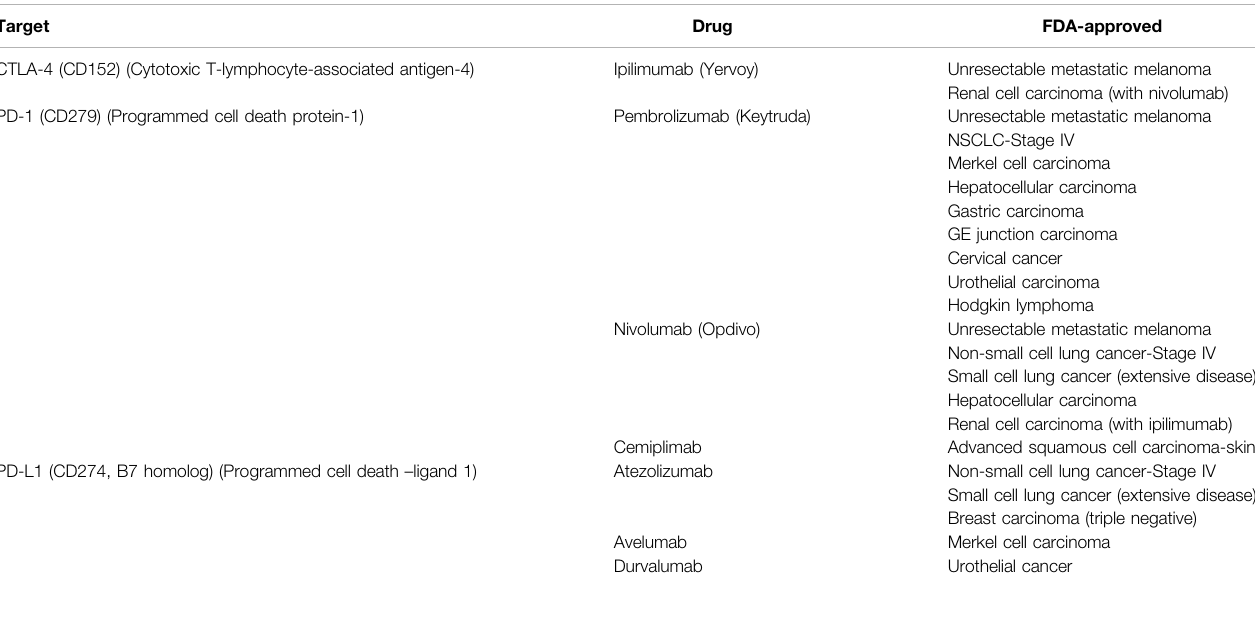
TABLE 1 | Immune checkpoint inhibitor drug class and associated FDA approved tumor